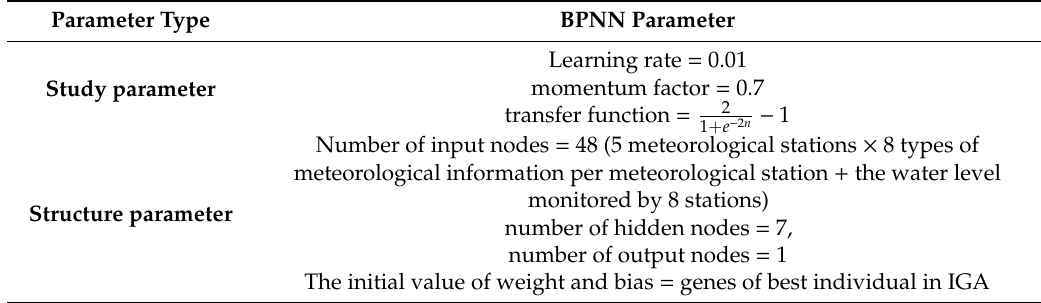
Table 5. Model parameters of back-propagation neural network (BPNN) used for the training and testing of models.